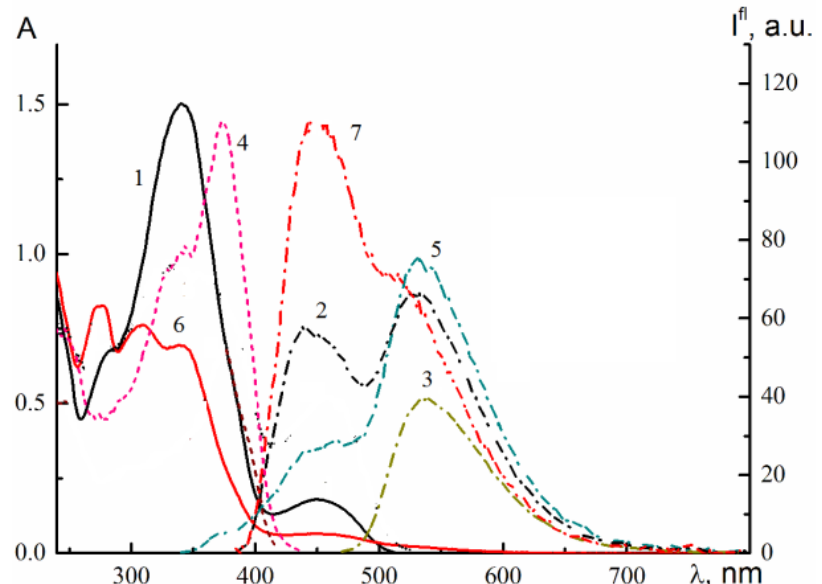
Figure 4. Absorption spectra (1, 6), fluorescence spectra at λ ex = 332 nm (5), 375 nm (2, 7), 461 nm (3) and fluorescence excitation spectra at λ reg = 461 nm (4) before (1–5) and after (6, 7) UV irradiation by the external source of model 3 in ethanol solution